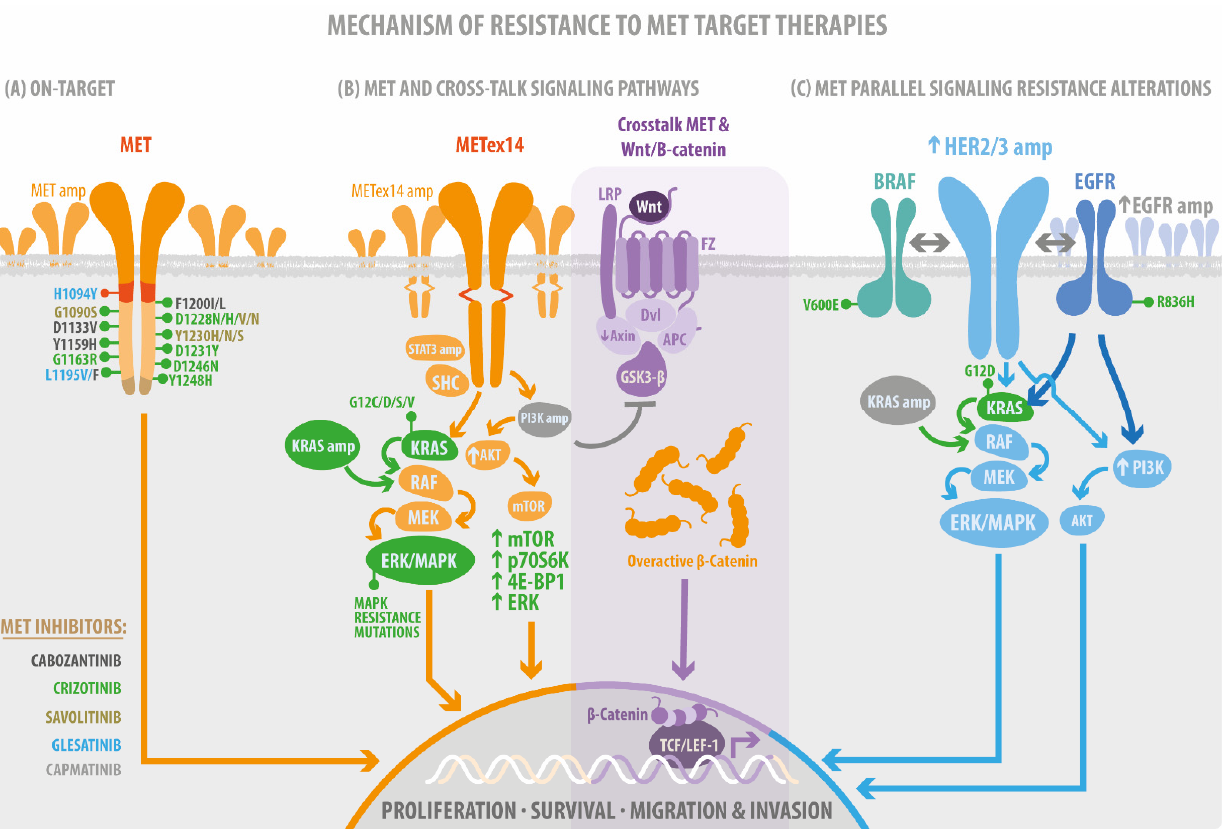
Figure 2. Mechanism of resistance to MET target therapies. ( A ) the on-target resistance mutations. These mutations impacted the Juxtamembrane domain (RED) and the Tyrosine kinase domain (orange). The multi-docking site (brown) without evidence of resistance mutations. ( B ) Canonical MET signaling pathways acquire resistance mutations such as STAT, PI3K, and KRAS amplification (amp), AKT, mTOR signaling overexpression (arrow up), KRAS mutations, and crosstalk’s mediate PI3Kamp and GSK3b inhibition, Axin downregulation (down arrow) followed by overactivation of b-catenin signaling. ( C ) The acquired resistance mutations impact the MET parallel receptor tyrosine kinase signaling after using MET-TKI. Therefore, the colors of the target drugs (MET inhibitors) are related to the color of mutations.